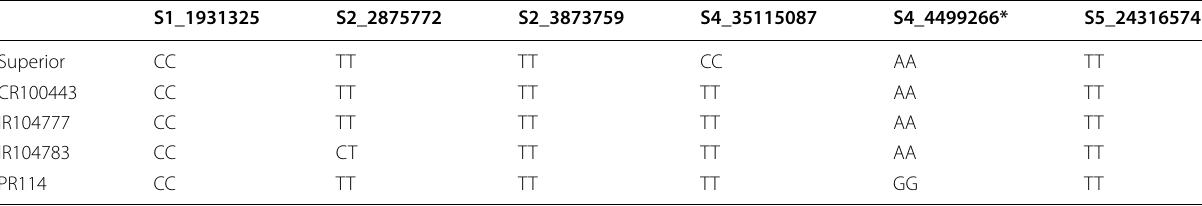
Table 8 The list of O. rufipogon accessions possessing combination of superior alleles at significant SNP positions associated with HGW where SNPs marked with * represent alleles absent in indica cultivars